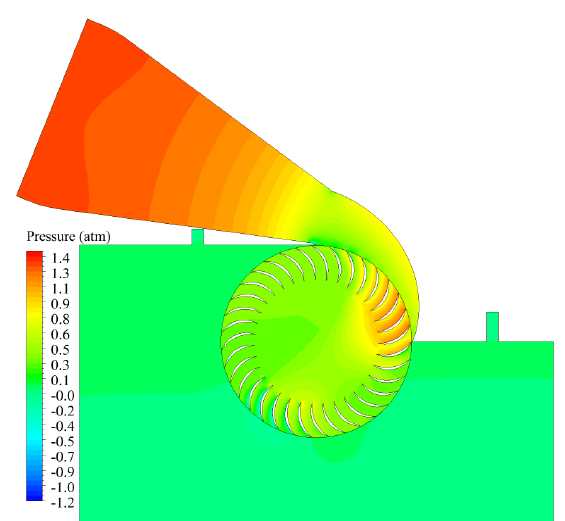
Figure 17. Pressure